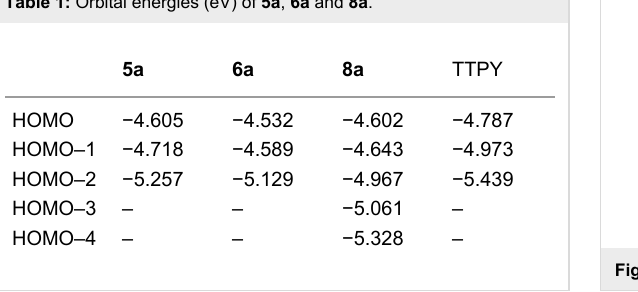
Table 1: Orbital energies (eV) of 5a , 6a and 8a .